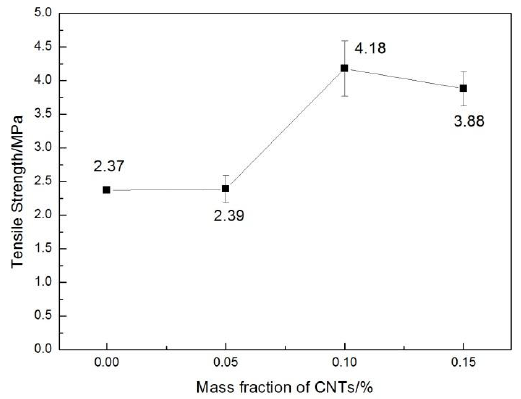
Figure 4. The effect of CNT content on the tensile strength of CNT/WPCs specimens by SLS.